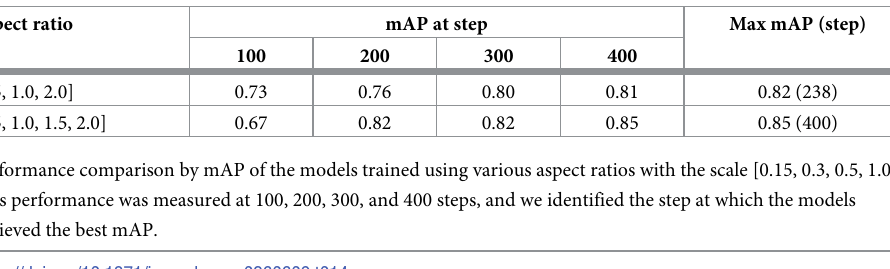
Table 14. Comparison of detection results with various aspect ratios and the scale [0.15, 0.3, 0.5, 1.0]. Aspect ratio mAP at step